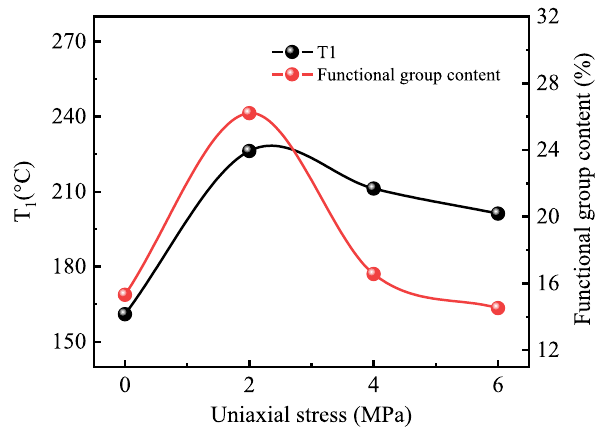
Fig. 7 Comparison curve of hydroxyl content and temperature T under uniaxial